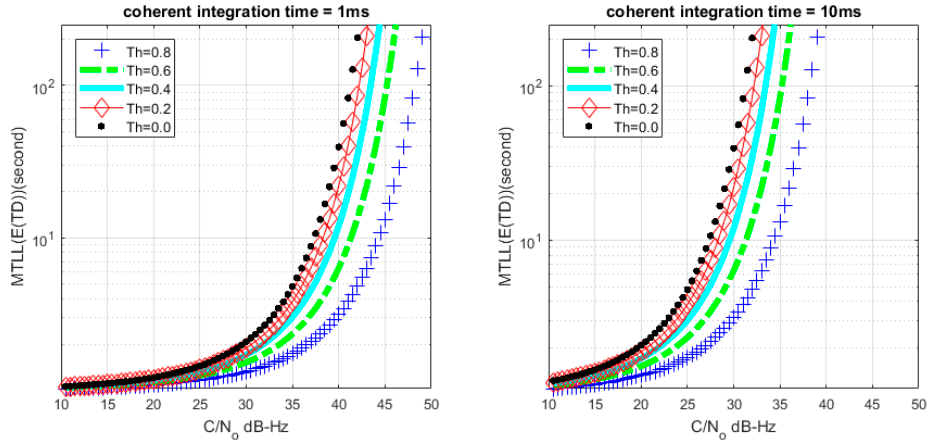
{ } E T Figure 8. Relation between mean-time-to-lose-lock (MTLL) ( E { T D } ) and C / N 0 ( M = 1) under signal D